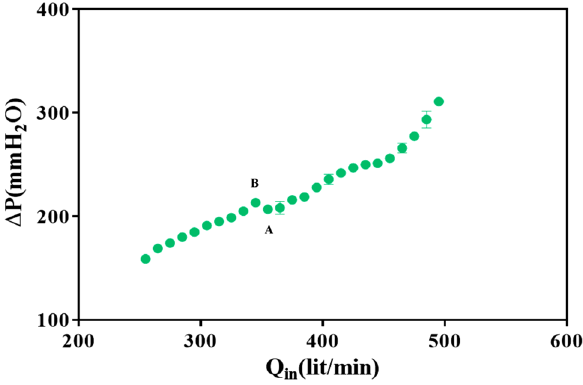
Figure 2. Pressure drop (∆P) versus the inlet air flow rate (Q in